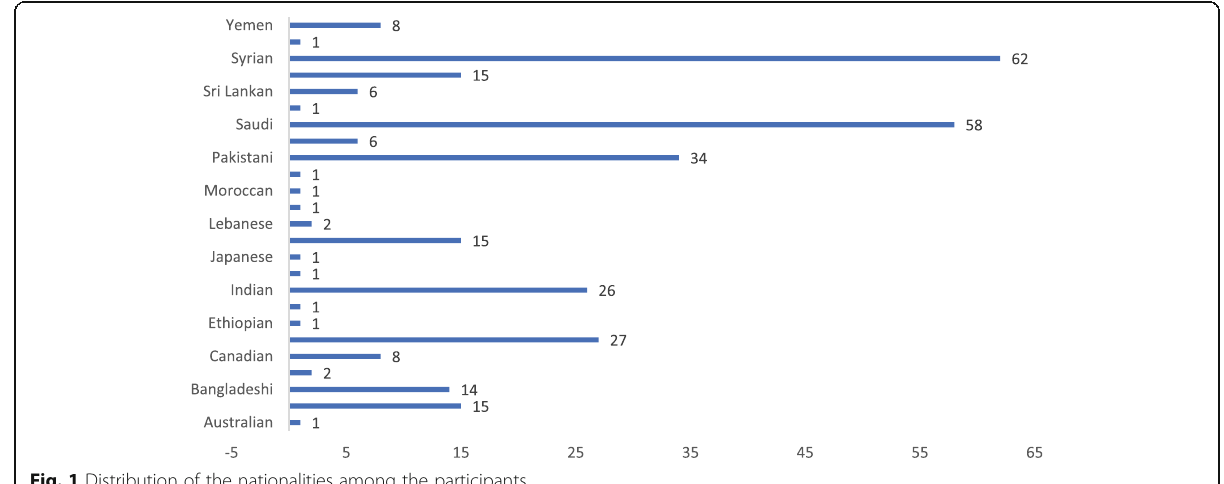
Fig. 1 Distribution of the nationalities among the